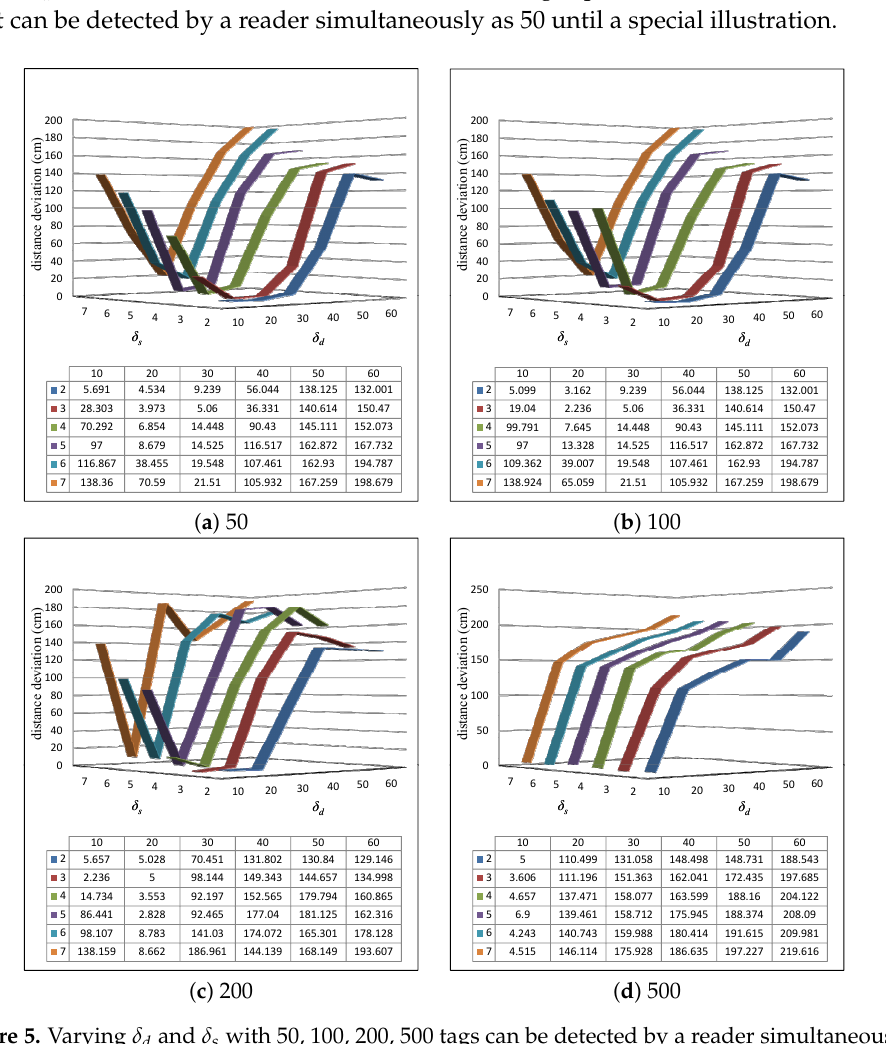
Figure 5. Varying δ d and δ s with 50, 100, 200, 500 tags can be detected by a reader